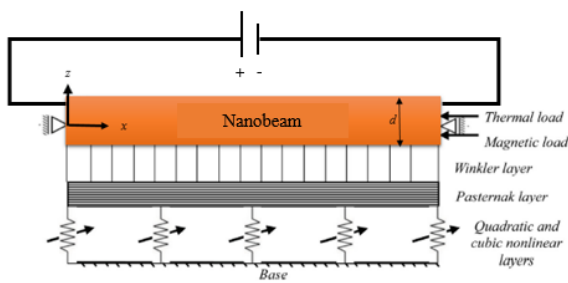
Figure 1: A piezoelectric nanobeam embedded in linear and nonlin- ear elastic media. (Note: only the bottom side of the elastic media is shown)